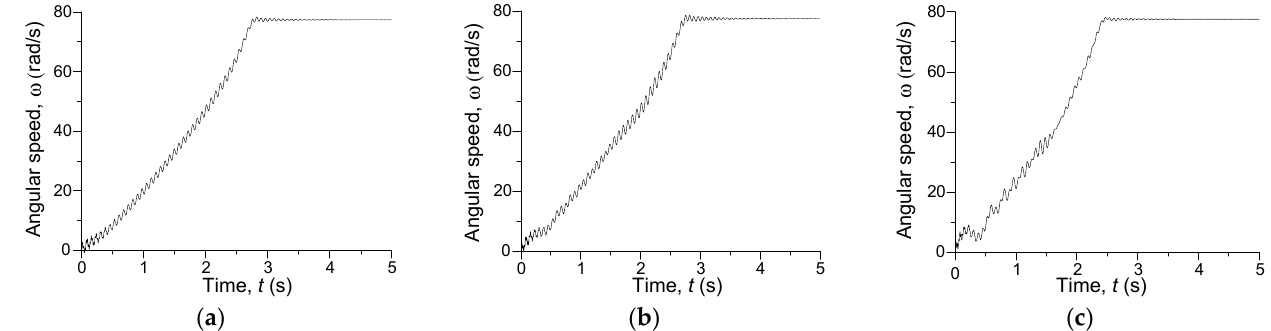
Figure 8. Angular velocity of motor rotor versus time for the shaft diameter D = 0.1 m and three angles between the adjacent shafts: ( a ) α 1,2 = α 2,3 = 0; ( b ) α 1,2 = α 2,3 = π /8; ( c ) α 1,2 = α 2,3 = π /5.